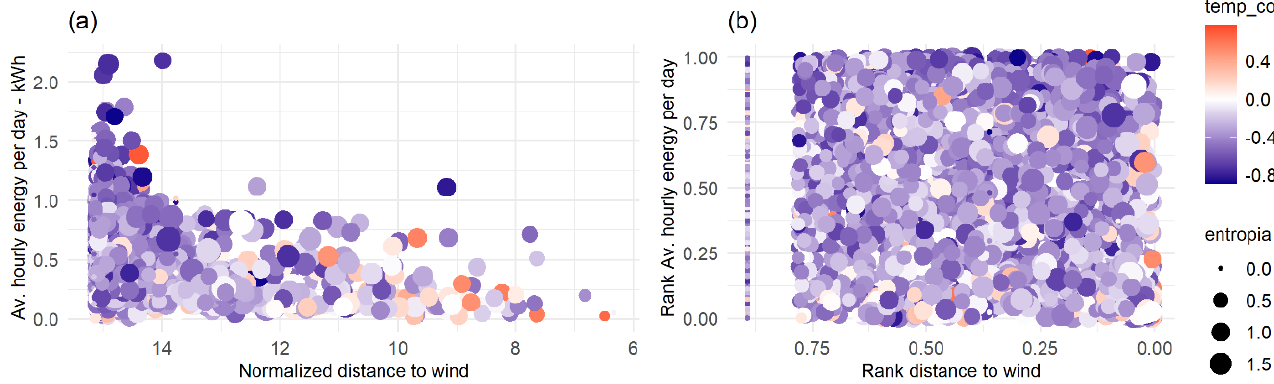
Figure 12. Visualization of customers’ DR potential according to features. ( a ) Average hourly energy and distance to wind in absolute values. ( b ) Same representation in percentiles.